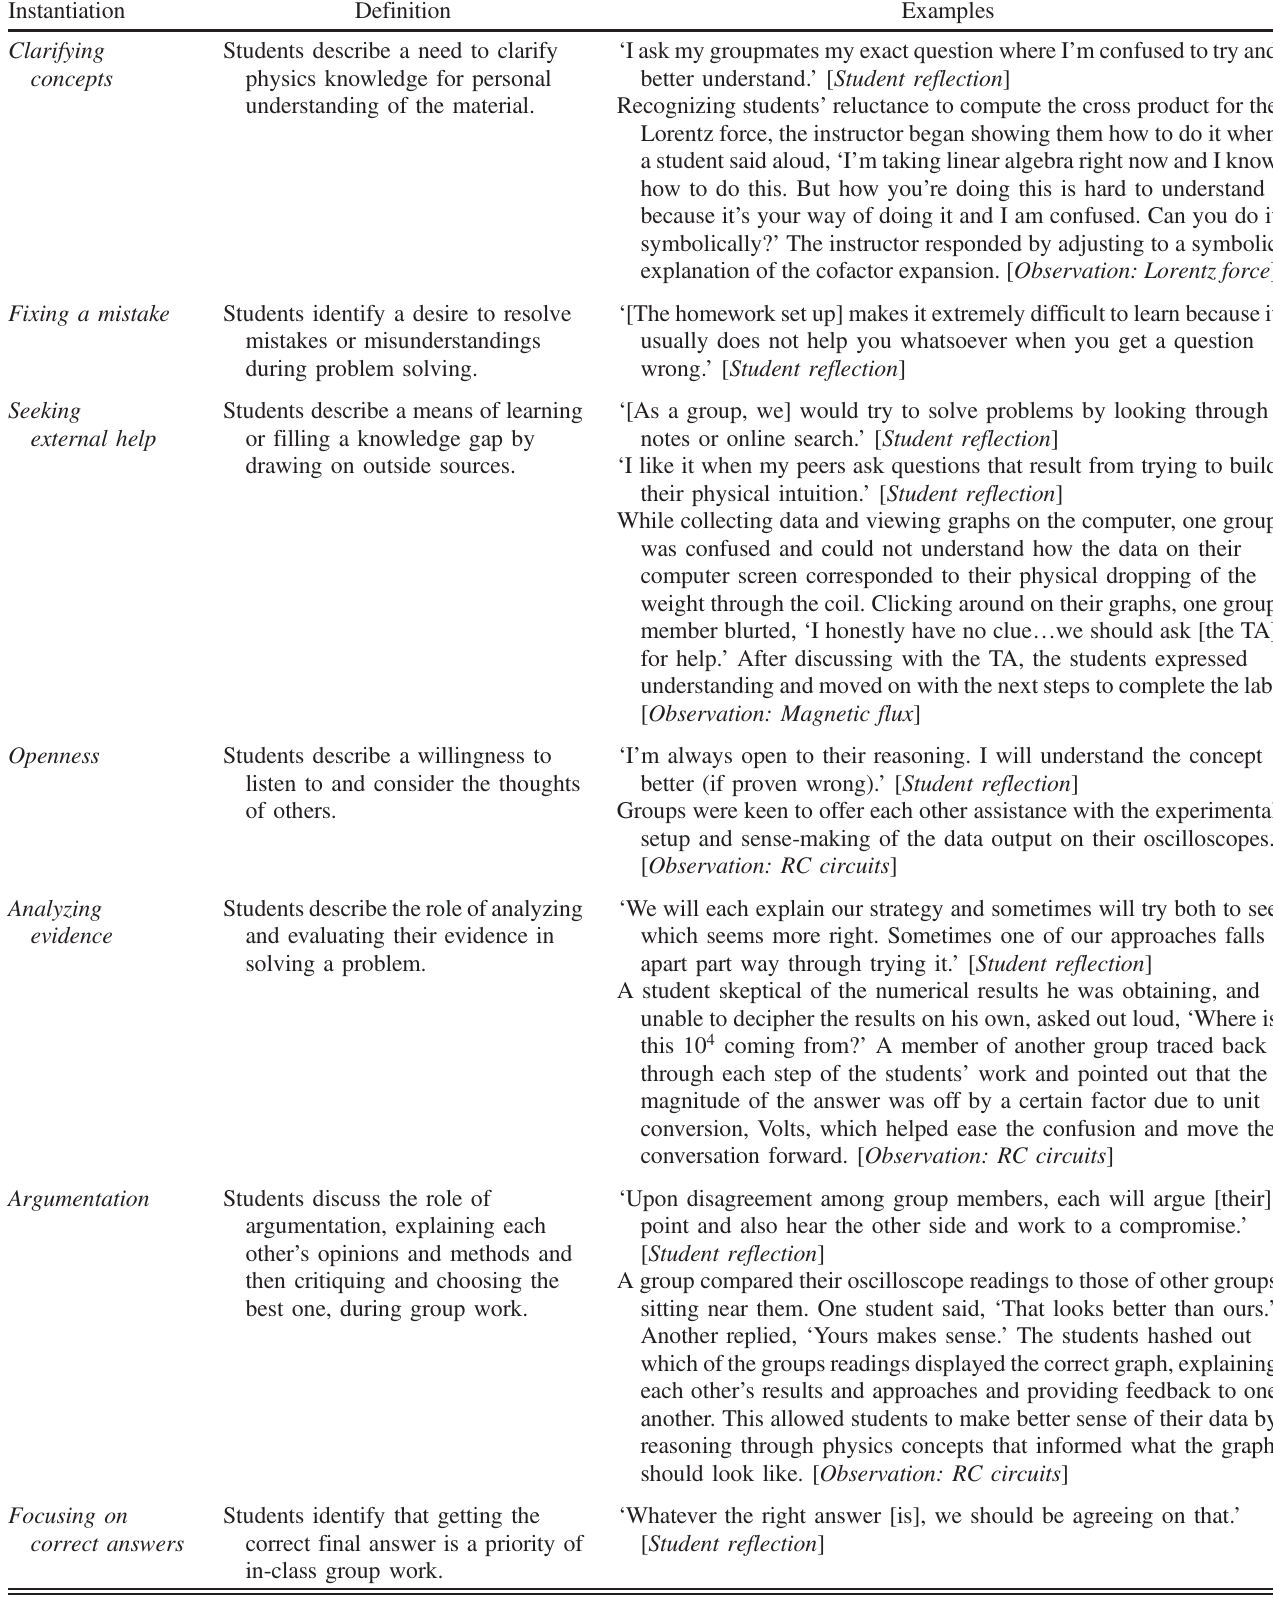
TABLE II. Definitions and examples of instantiations related to love of